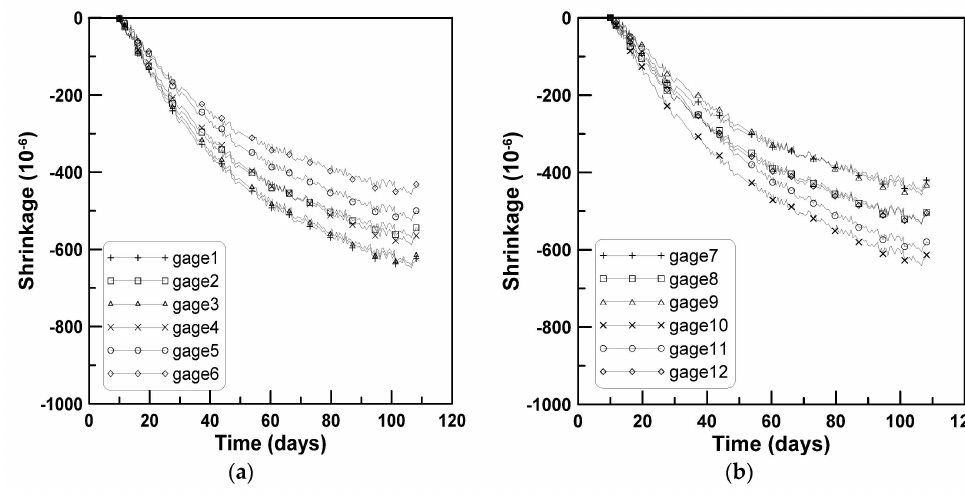
Figure 7. Shrinkage strains of vertically-cast beam specimens of test series C: ( a ) Specimen 1; ( b ) specimen 2.